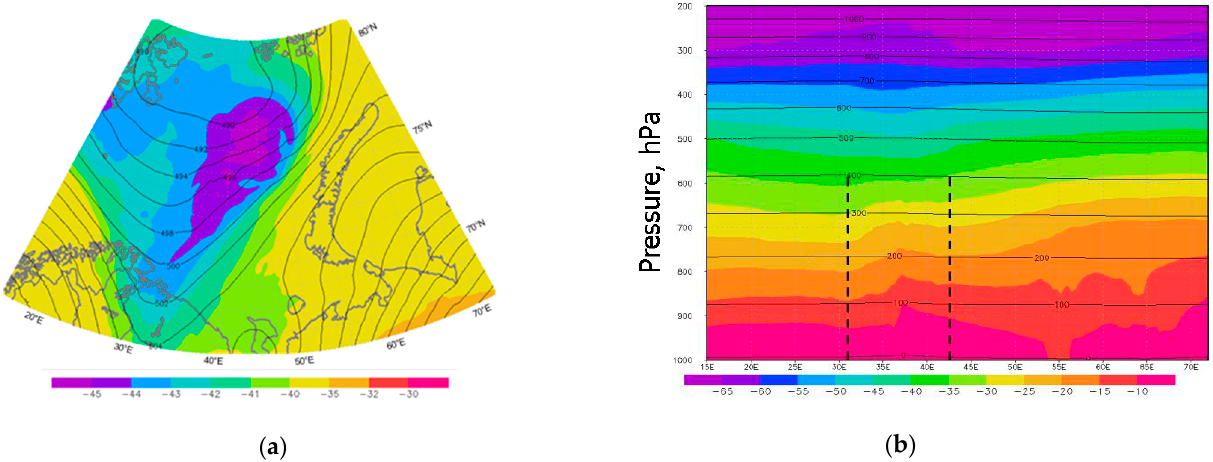
Figure A5. Wind speed forecast on 12:00 UTC 20 March 2020 by ICON-A6.5; ( a ) forecast for 36 h from 00:00 UTC 19.03; ( b ) forecast for 12 h from 00:00 UTC 20.03.